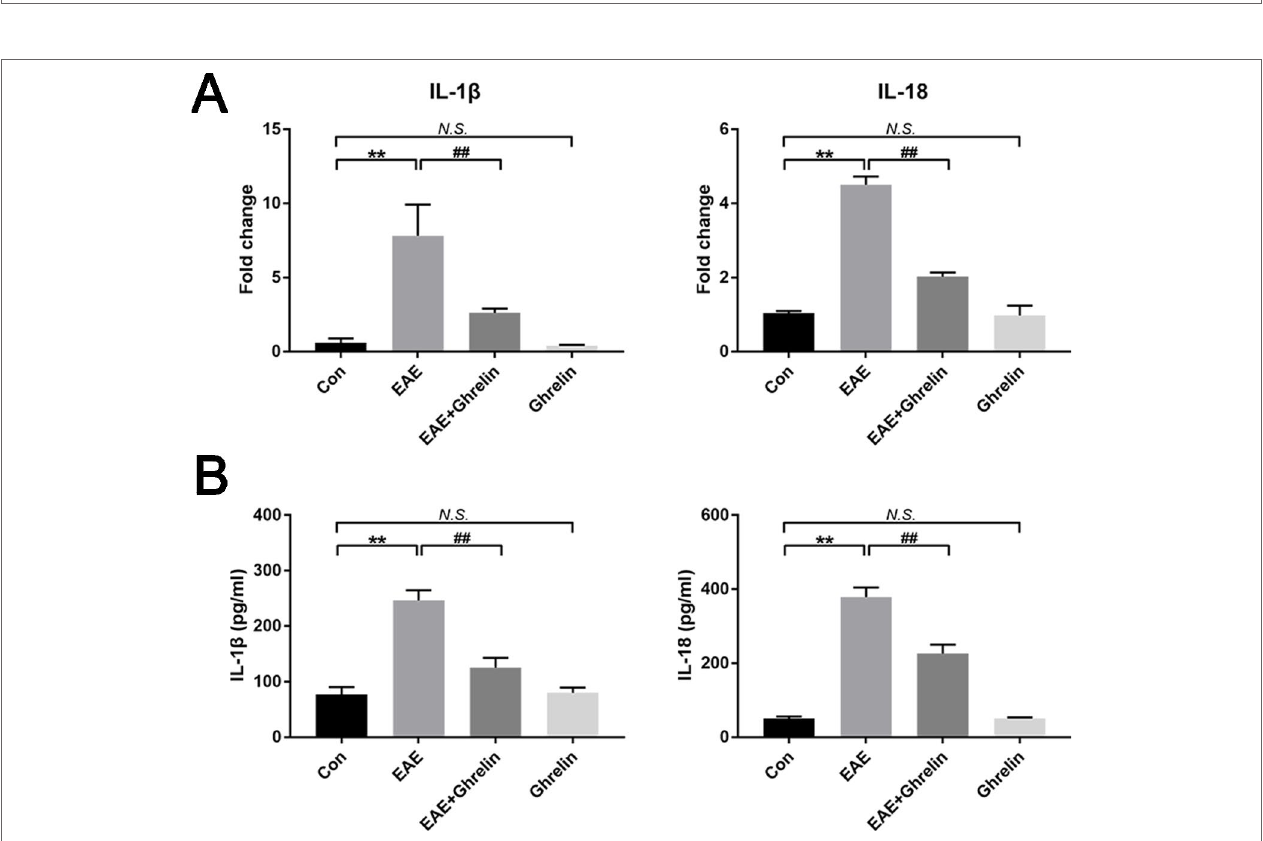
FIGURE 5 | Treatment of ghrelin downregulated expressions of IL-1β and IL-18. (A) The mRNA expressions of IL-1β and IL-18 were measured by quantitative RT-PCR ( n = 5). (B) IL-1β and IL-18 expressions in serum were measured by ELISA ( n = 10). Data were shown as mean ± SD. ** P 0.01 versus the control group, ## P 0.01 versus the EAE group. NS , not significant. Con,